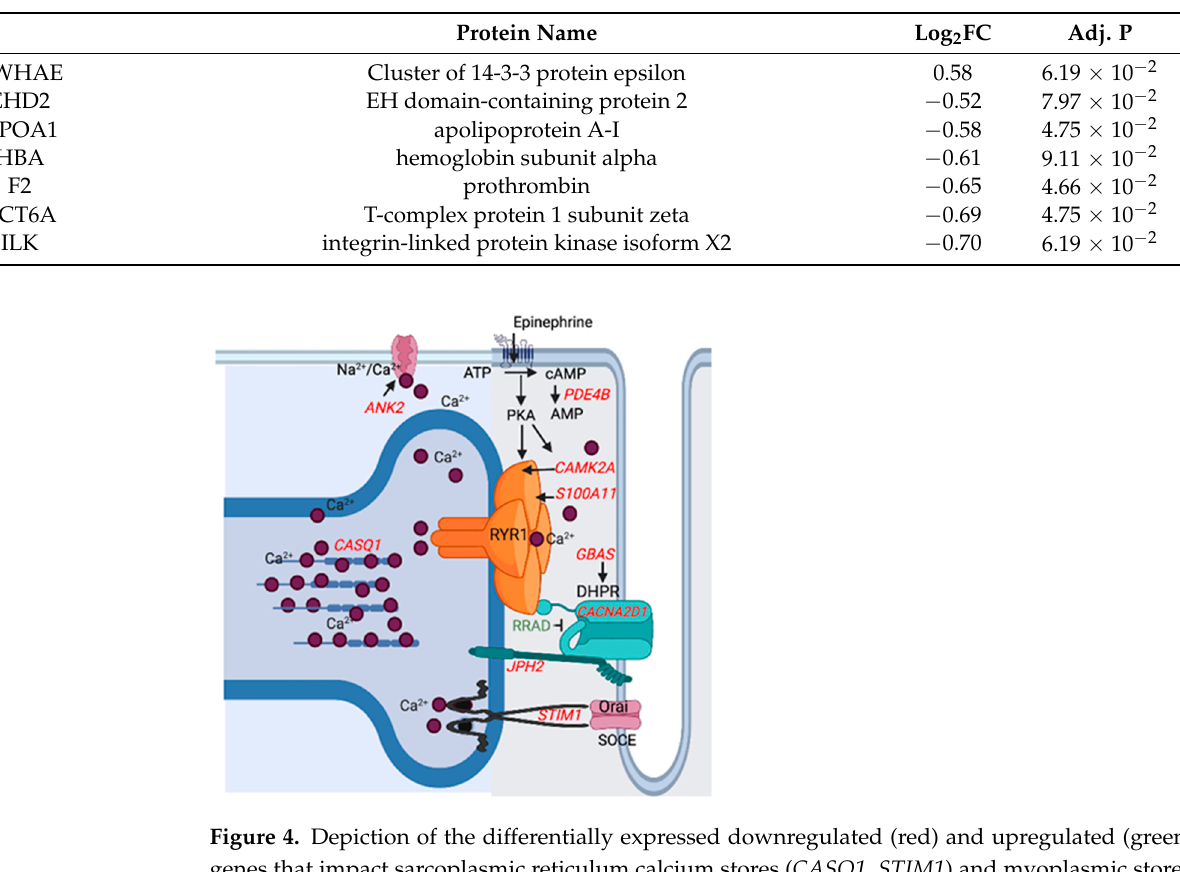
11 genes), and dihydrolipoyl dehydrogenase (1 GO term, 3 genes) (Table S4).